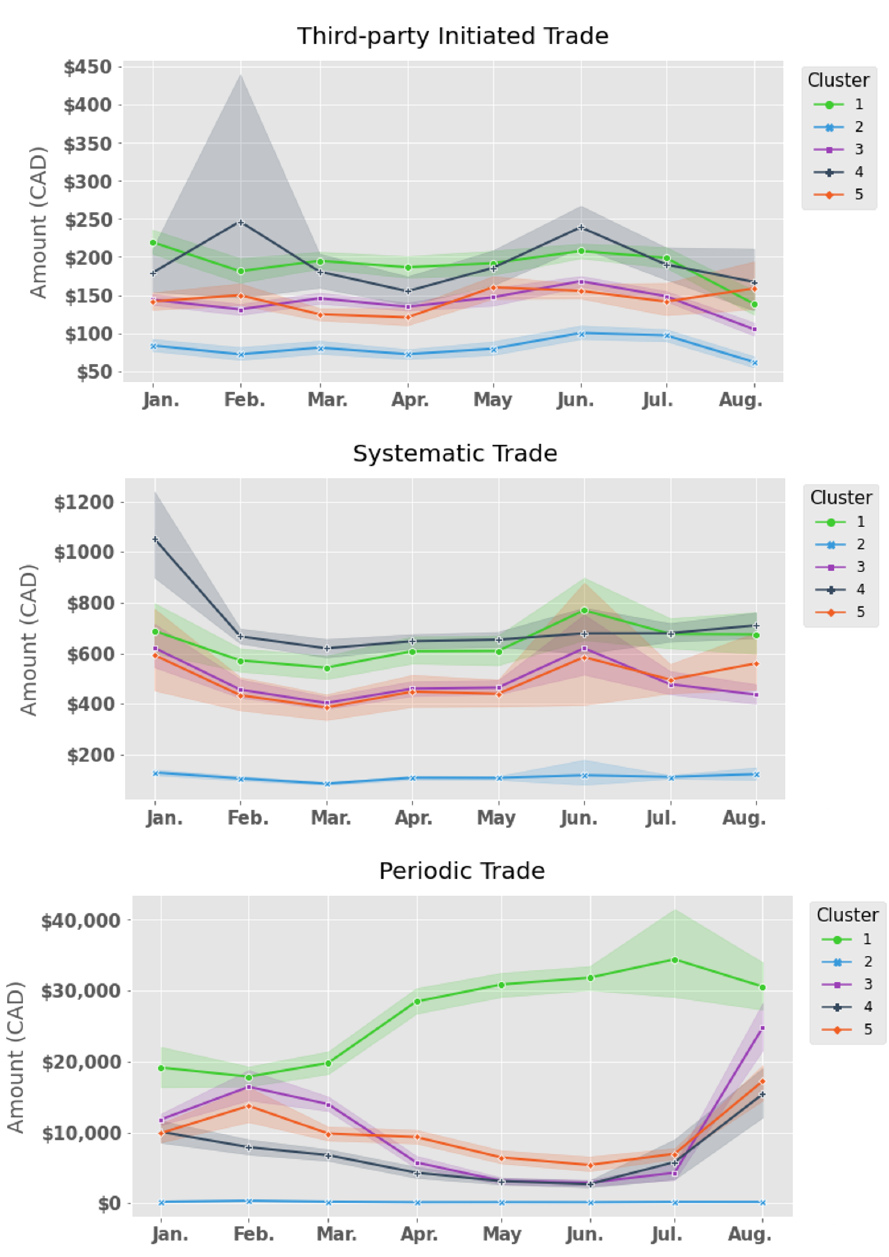
Figure 8. Cluster average trading amounts with 95% bootstrapped confidence intervals versus time. ( Top ), ( middle ), and ( bottom ) panels correspond to third-party-initiated trades, systematic trades, and periodic trades,